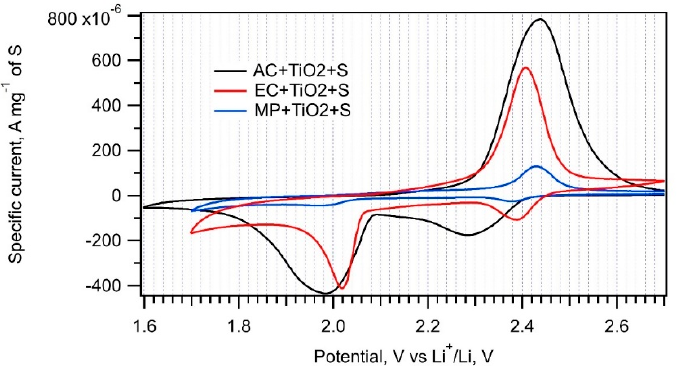
Figure 7. Cyclic voltammograms of the EC + TiO 2 + S, AC + TiO 2 + S and MP + TiO 2 + S samples recorded with a scan rate of 0.1 mV s − 1 .